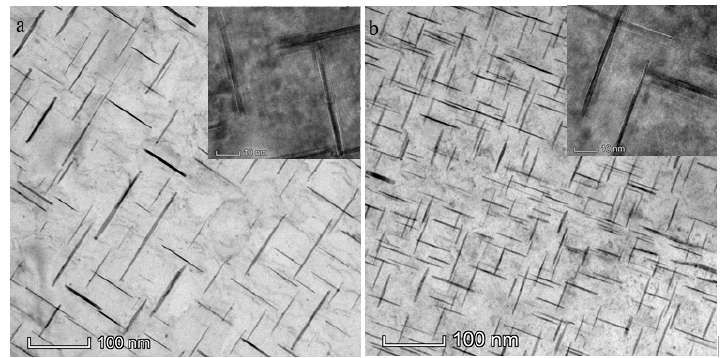
Figure 6. TEM images of strengthened θ ’ phases at peak aging of ( a ) single-wire wall and ( b ) double-wire wall.